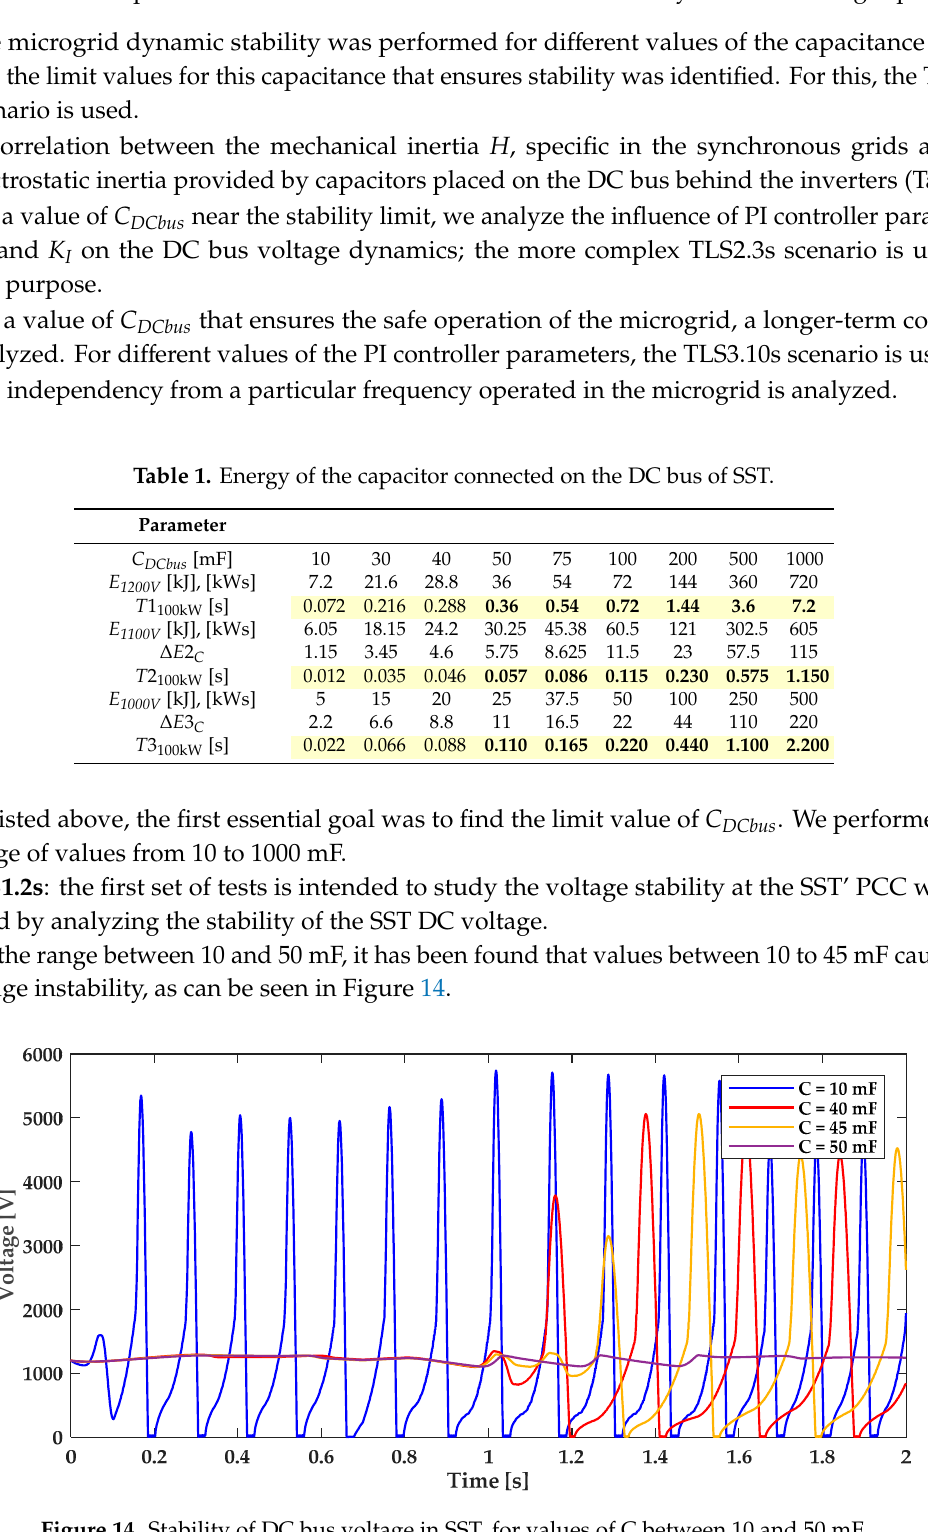
Figure 15. Stability of DC bus voltage in SST, for values of C between 50 and 500 mF. A relevant aspect to be analyzed when considering the capacitor as a source of “inertia” for the microgrid is the capacitor’ energy. In frequency dependent grids, the kinetic energy can be deployed in seconds. It means the time needed to consume the rotating inertia energy at the total load of the grid. Usual values are H from 1 to 7 per unit seconds (e.g. 6.3 seconds for nuclear units down to 3 seconds for conventional hydro and 1 second for small hydro, as per [44], while earlier studies show, e.g, that Japanese systems had an inertia constant of 14 to 18 seconds [45]). For the former, it is assumed that the energy is provided by all rotating machines, while in due time the primary frequency control loop is activated to contribute to the frequency recovery. The disturbance can be seen in the rate of change of frequency (RoCoF), which should be up to a few Hz/s to ensure the system stability.